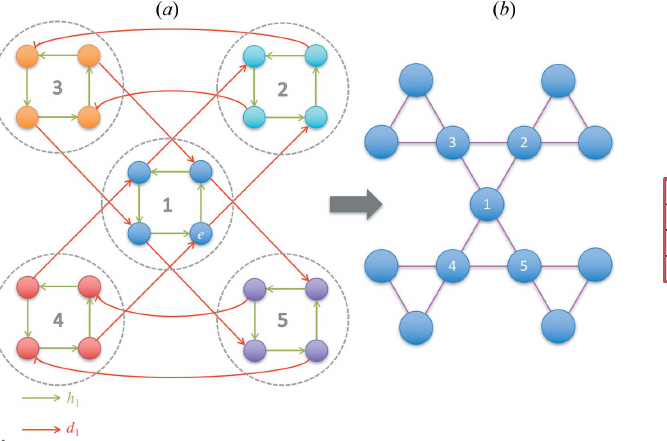
Figure 4 The formation of twin boundaries and dislocations between vertices 1 and 2 of Fig. 3( b